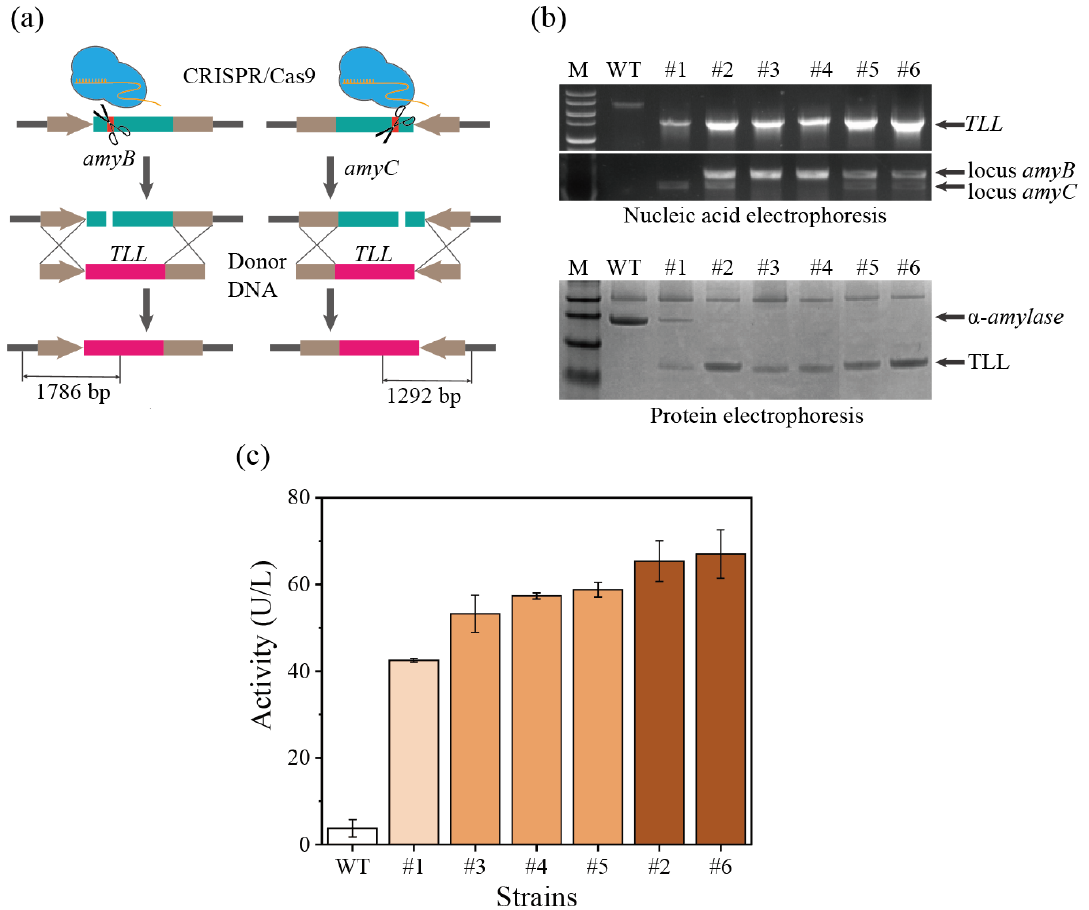
Figure 4. Integrative expression of TLL in A. oryzae . ( a ) Schematic diagram of the integrated expression of TLL in A. oryzae . The indicated sequence lengths were used to verify different integration sites using primers Locus-amyB-F, Locus-amyC-F, and Locus-TLL-R, respectively. ( b ) Different electrophoretic validation of TLL integrated expression. Nucleic acid electrophoresis showed that the TLL gene was successfully integrated into amyB or/and amyC sites, and protein electrophoresis showed that the integration of multiple copies was beneficial to improve the expression level of TLL. ( c ) Lipase activity after integrated expression of TLL in A. oryzae . n = 3. #1–6 represented the selected positive